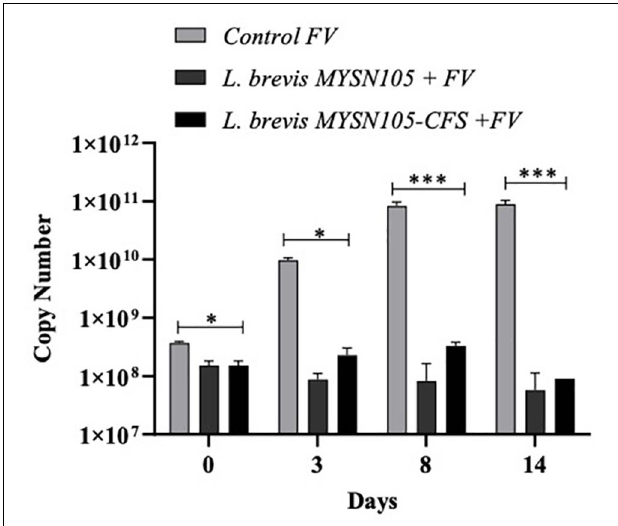
FIGURE 8 | Quantitative PCR amplification of F. verticillioides using ITS primer. ITS copy number quantified using Cq values. Data shown are mean ± SE of triplicate values of two independent experiments and differ significantly ( ∗ p < 0.05, ∗∗∗ p < 0.001).